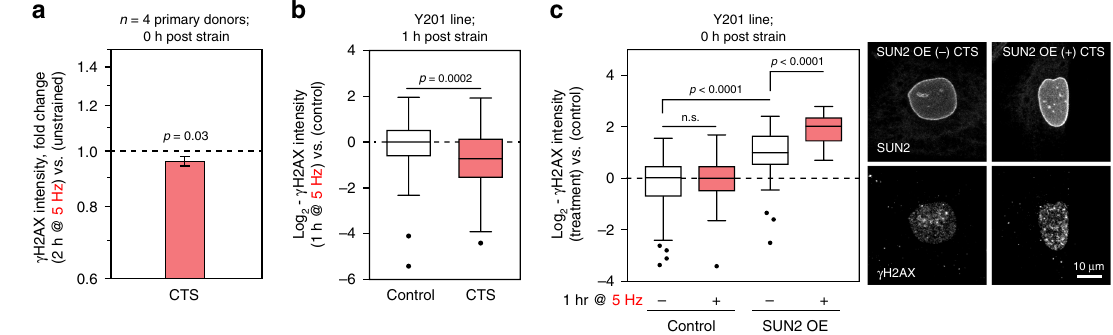
Fig. 9 γ H2AX staining is increased in SUN2 OE hMSCs subjected to CTS. a The integrated intensity of γ H2AX stained foci was signi fi cantly decreased